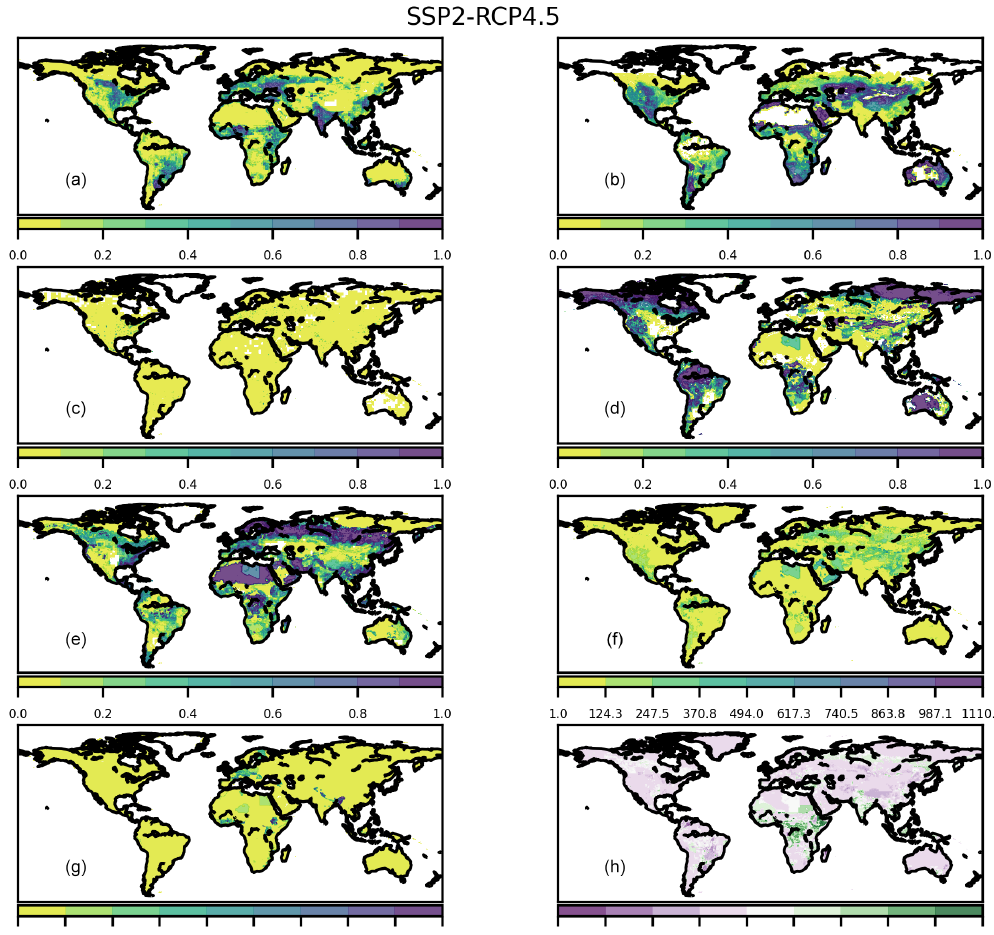
Figure 13. Maps for the year 2100 for the SSP2-RCP4.5 scenario showing the following: (a) the fraction of each grid cell occupied by cropland; (b) the fraction of each grid cell occupied by pasture; (c) the fraction of each grid cell occupied by urban land; (d) the fraction of each grid cell occupied by primary vegetation; (e) the fraction of each grid cell occupied by secondary vegetation; (f) the mean age (in years) of secondary lands in each half-degree grid cell; (g) the mean gross transitions (km 2 yr − 1 ) over a 20-year interval for each grid cell; and (h) the mean net transitions (km 2 yr − 1 ) over a 20-year interval for each grid